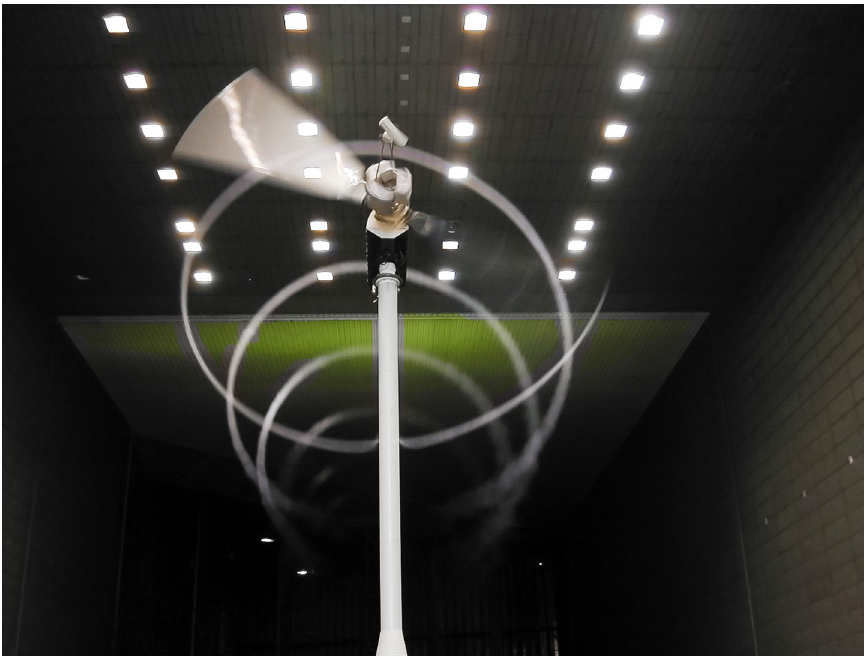
Fig 2. Smoke visualization of a blade-tip vortex at the national aeronautics and space administration’s ames research center 40-by-80-ft wind tunnel. The visible helical vortex indicates the region of low pressure caused by the blade-tip vortex. Note that this visualization was performed under low-turbulence conditions in a wind tunnel, allowing the vortex to advect downwind with the mean flow with its helical structure intact. In the atmosphere, where the turbulence intensity is typically much higher, the vortex structure is commonly unrecognizable within one rotor diameter downstream of the rotor plane. Photo by Lee Jay Fingersh, National Renewable Energy Laboratory, 55062.